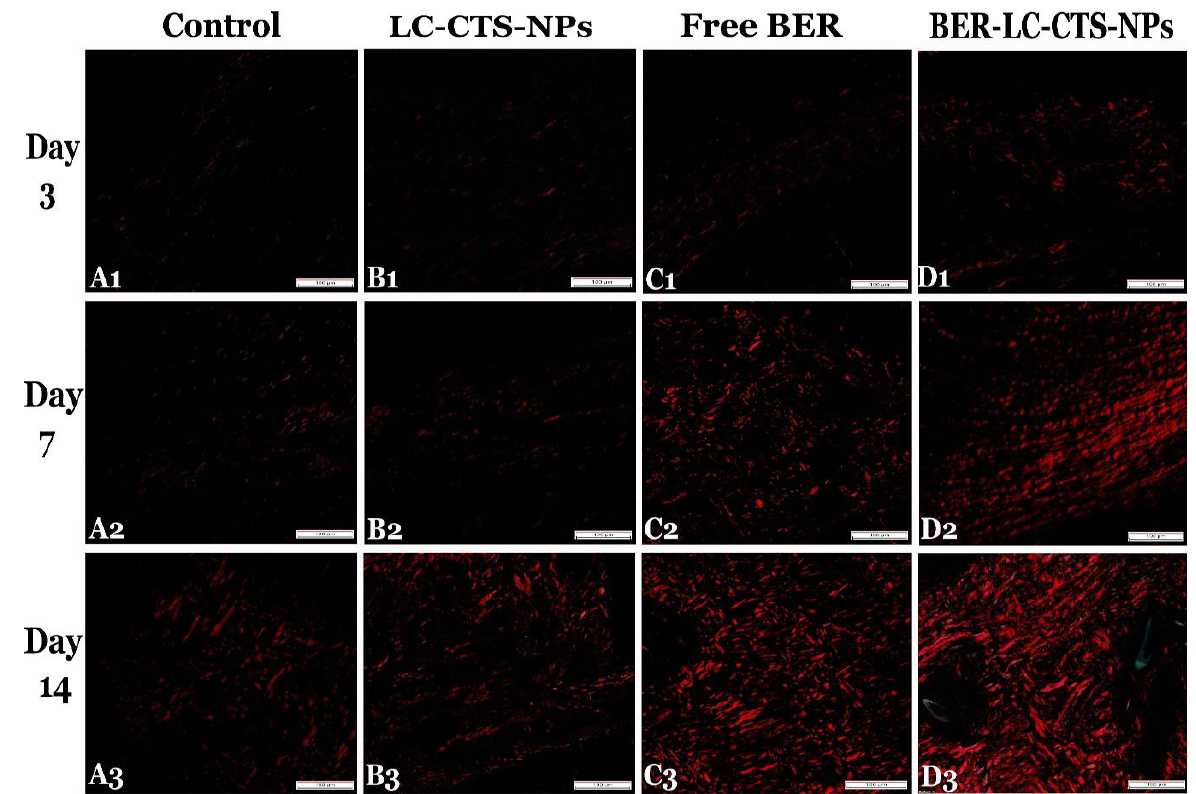
Figure 10. Representative skin sections on days 3, 7, and 14 post wound creation, stained with Picrosirius red stain (Polarized-field view × 200) for mature collagen fibers quantification in the diabetic rats of the Control ( A1 – A3 ), LC-CTS-NPs ( B1 – B3 ), Free BER ( C1 – C3 ), and BER-LC-CTS-NPs ( D1 – D3 ) groups. Note: in all days, the largest amount of mature fibers was formed in the BER-LC-CTS-NPs treated group ( D1 – D3 ) and was organized on day 14 as thick short bundles running in the same direction ( D3 ).